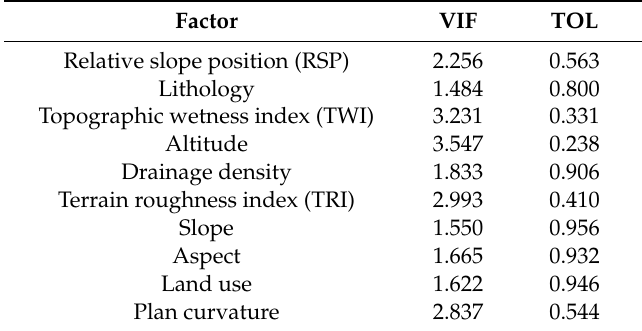
Table 2. Multicollinearity of predictive factors based on the variance inflation factor (VIF) and tolerance (TOL)